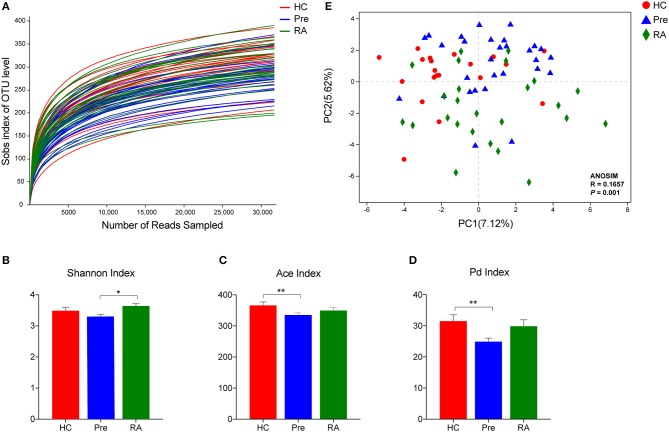
Oral microbiota community characteristics in high-risk individuals (Pre), RA patients and healthy controls (HCs). (A) Rarefaction curves showing the number of bacterial sequences obtained are saturated. Alpha diversity was calculated using Shannon diversity index (B), Ace community richness index (C), and the Faith's phylodiversity index (D), revealing a distinct feature in high-risk individuals. (E) Beta diversity demonstrated that samples clustered showed a tendency of gradual change from healthy subjects, high-risk individuals to RA patients. *p < 0.05 and **p < 0.01.